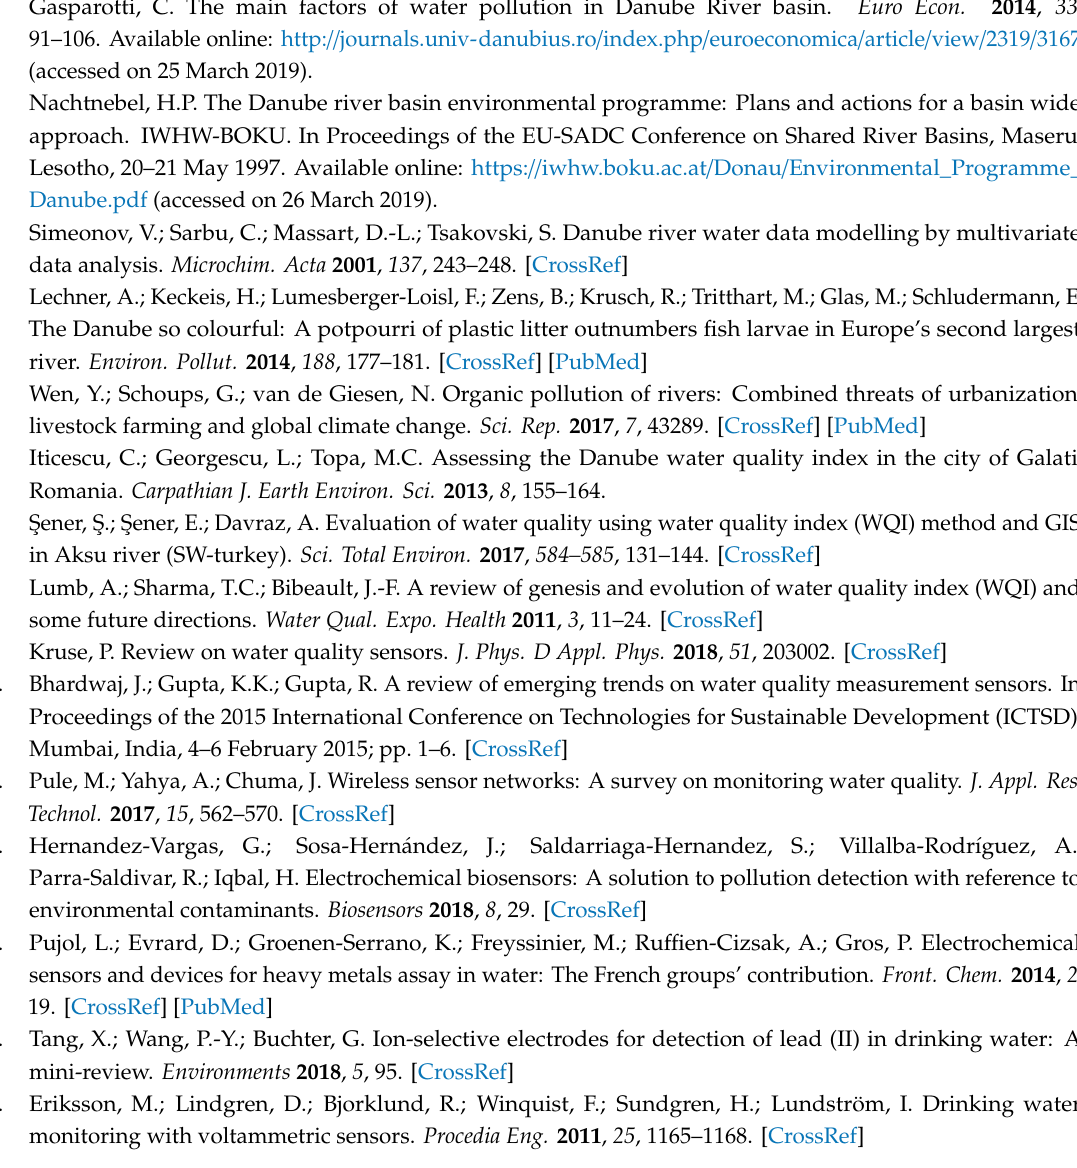
Figure S1: Sensor response (a) CoPc-SPE; (b) MB-SPE; (c) PB-SPE; (d) MWCNT / GNP-SPE; (e) MWCNF / GNP-SPE; (f) MWGPH / GNP-SPE exposed to the 0.1 M KCl aqueous